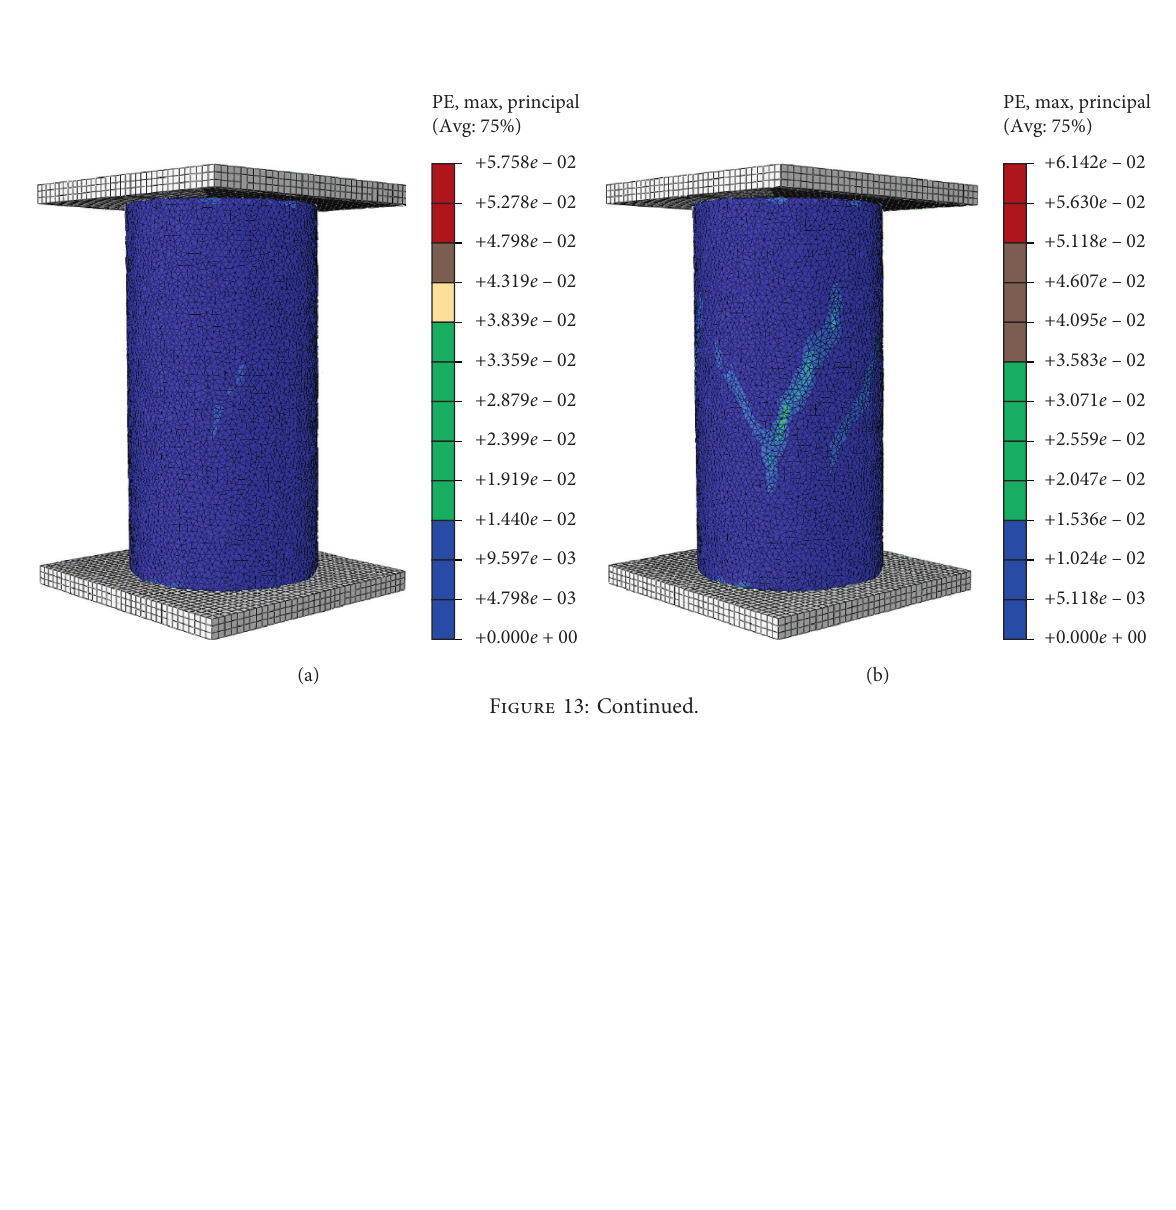
Figure 12: Uniaxial compression stress-strain curves of rock samples subjected to acid corrosion for 90